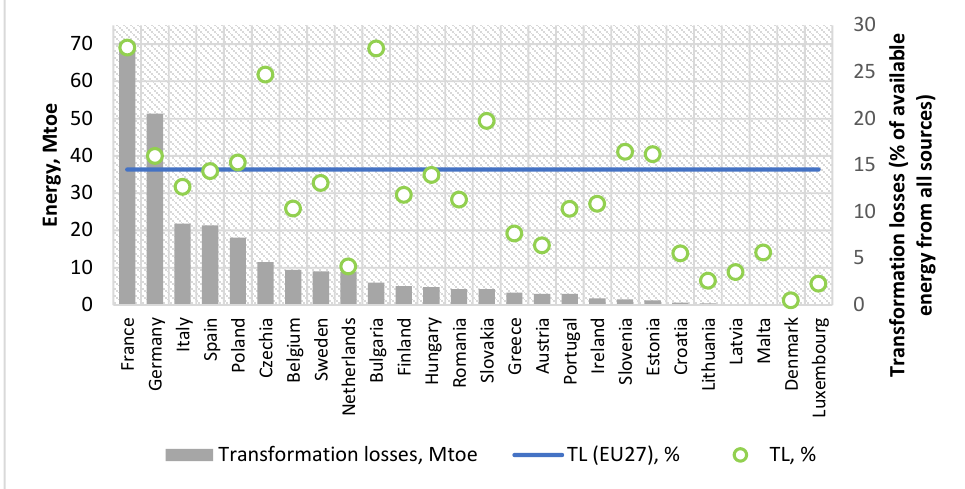
Figure 4. Transformation losses, 2020 (based on the Eurostat’s data (ec.europa.eu/eurostat/, accessed on 17 August 2022); © European Union, 1995 – 2022).